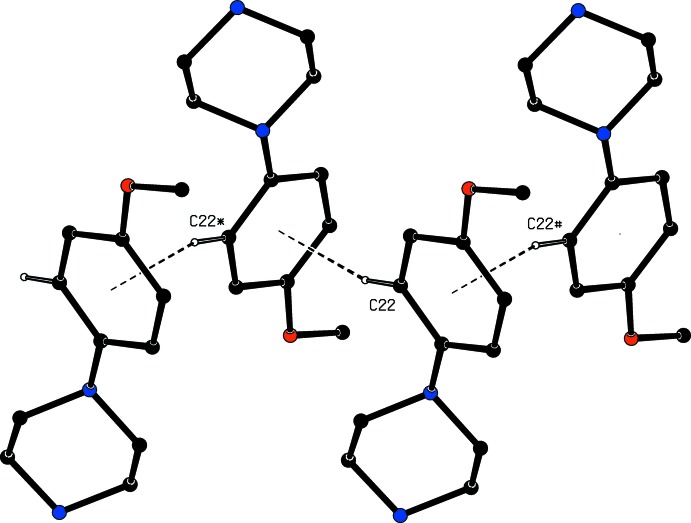
Part of the crystal structure of compound (III), showing the formation of a hydrogen-bonded chain of cations along [010]. Hydrogen bonds are drawn as dashed lines and, for the sake of clarity, the unit-cell outline, the minor disorder components and the H atoms not involved in the motif shown have been omitted. The atoms marked with an asterisk (*) or a hash (#) are at the symmetry positions ( − x, − + y,  − z) and ( − x,  + y,  − z), respectively.